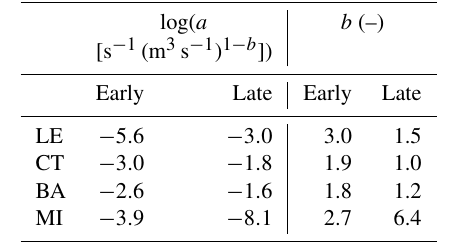
Table 2. Comparison of recession analysis parameters a and b for Lookout Creek between different methods: lower envelope (LE), central tendency (CT), binning average (BA), and the median indi- vidual recession (MI). Each value is represented as a ratio of pa- rameter estimation for early to late time. Depending on the fitting method, the parameter estimation for a and b will be